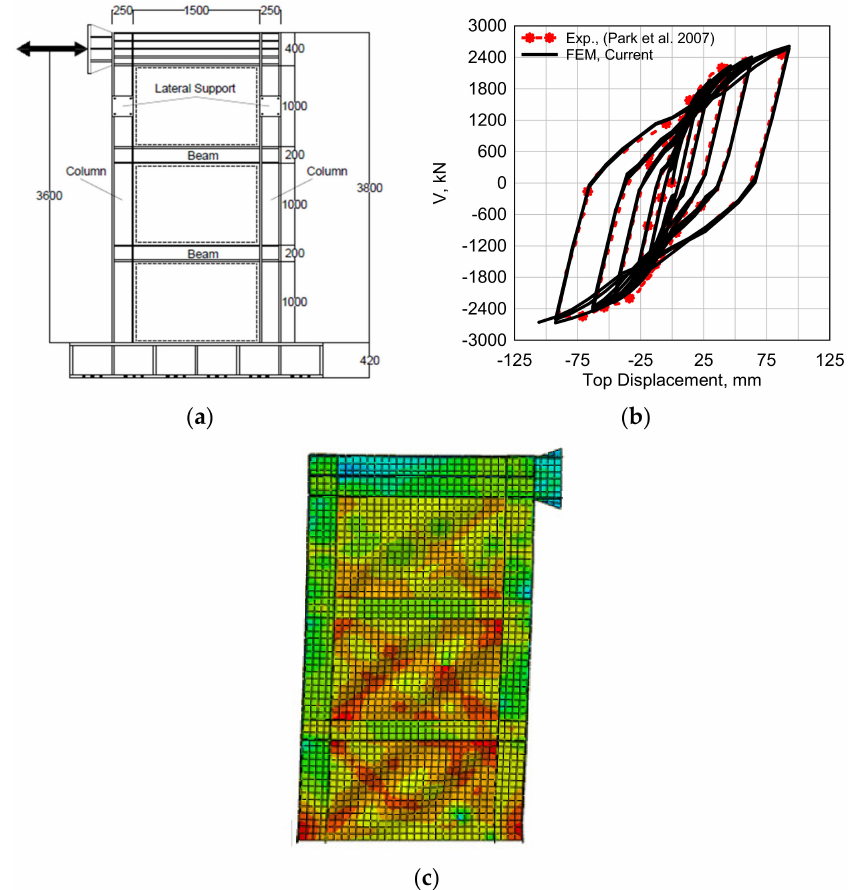
Figure 4. FEM validation; ( a ) Specimen details (dimensions in mm); ( b ) comparison between numeri- cal and experimental results; ( c ) FEM model deformed